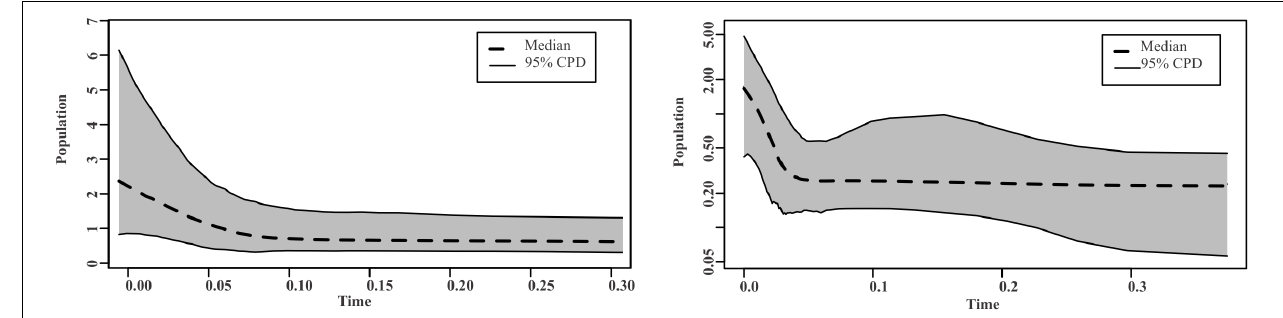
FIGURE 5 | Graphs of Bayesian Skyline Plots for the ITS region, β -tubulin, and Eap1 nuclear genes, showing a process of demographic expansion over time, assuming a divergence index of 2.18 and 4.94% Myr for S. reilianum in the region of Valle del Mezquital.